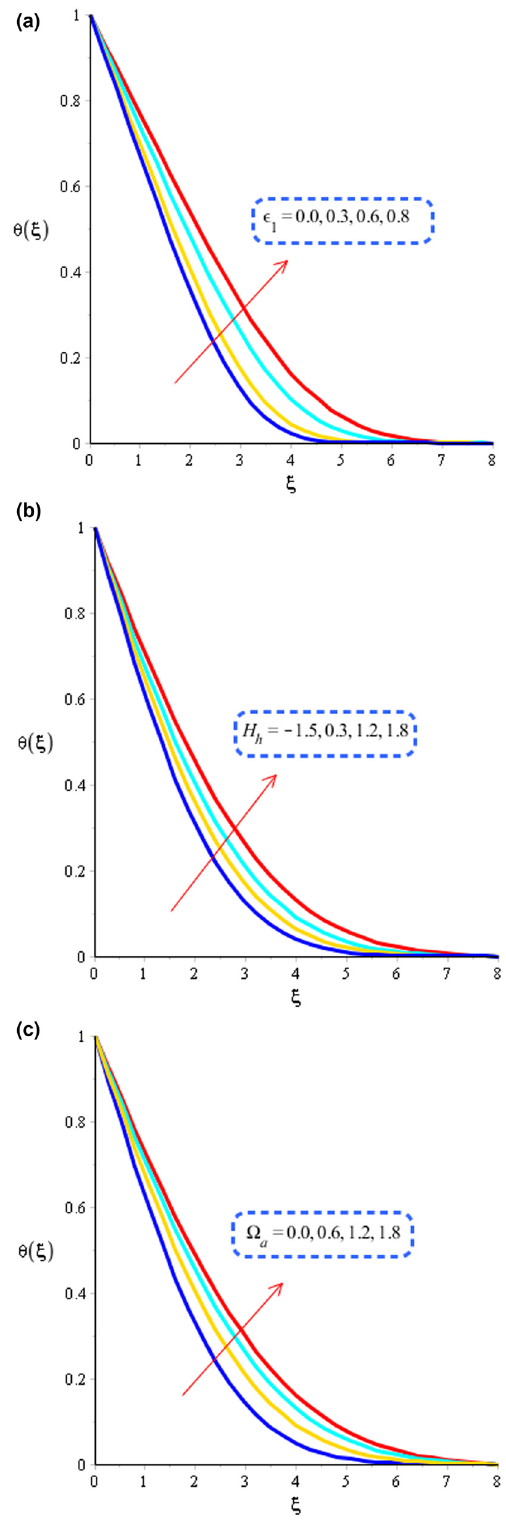
Figure 4: ( a ) Role of ε 1 on temperature curves. ( b ) Role of H h on temperature curves. ( c ) Role of Ω a on temperature